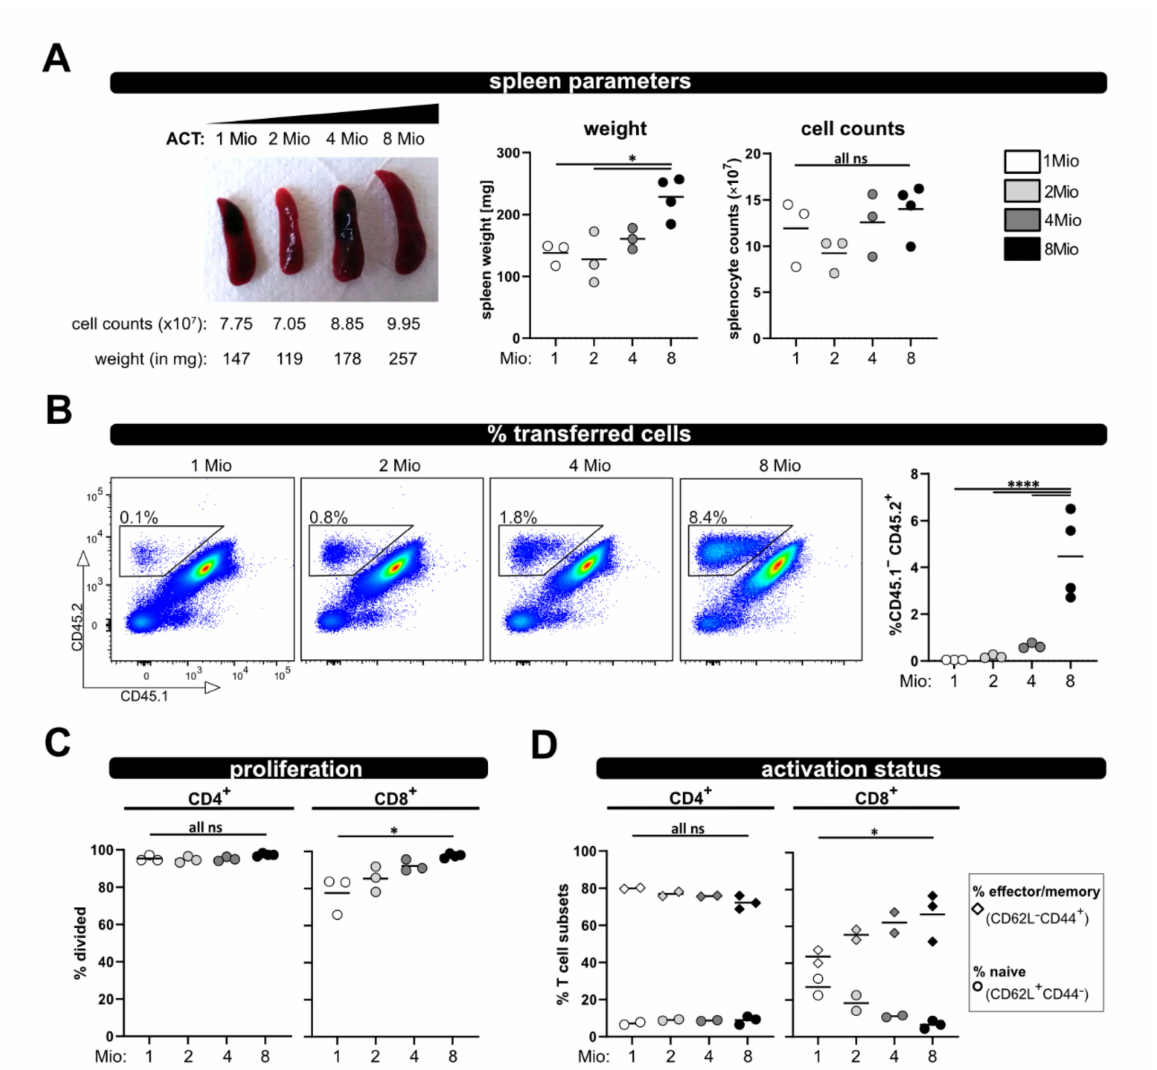
Figure 5. Titration of transferred T cell numbers. ( A ) Representative pictures of spleens on day 8 after transfer of 1, 2, 4 or 8 million wild type T cells are depicted. ( B ) Frequency of the transferred T cells among splenocytes and from blood at day 8 after ACT was determined by flow cytometry. ( C ) Proliferation and ( D ) T cell activation status (naive and effector/memory) of transferred wild type CD4 + and CD8 + T cells was analyzed at day 8 by CD62L and CD44 staining and flow cytometry. Data are represented as individual values plus mean. Representative FACS dot plots of individual mice are shown. ns = not significant, * p < 0.05, **** p < 0.0001; one-way ANOVA following